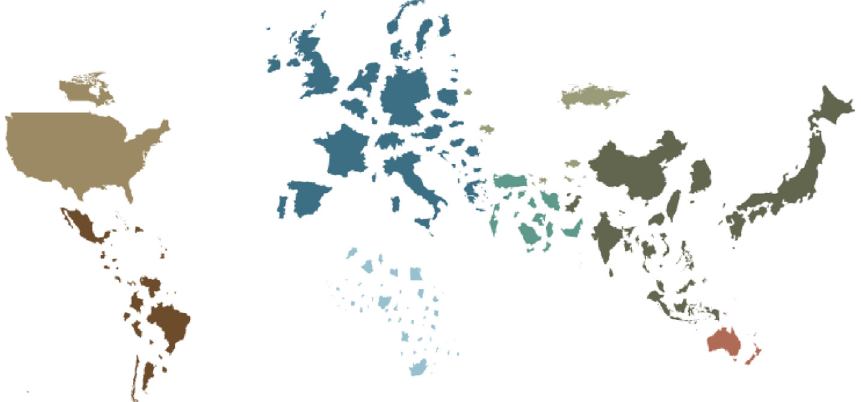
Figure 4. World map depicting countries in a size relative to their GDP (note the reversal of size distributions shown in Figure